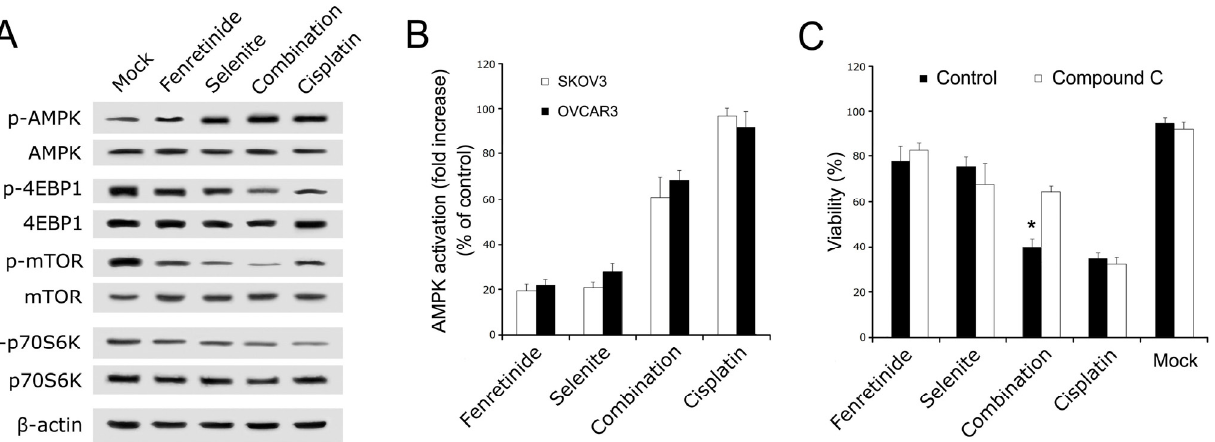
Figure 4. AMPK signaling pathway assay. After drug alone (10 µmol/L fenretinide, 10 µmol/L selenite) or drug combination (10 µmol/L fenretinide plus 10 µmol/L selenite) exposure for 48 h, Western blotting analysis for the expression of phosphorylated AMPK, 4EBP1, p70S6K and mTOR from AMPK signaling pathway ( A ); Cell-based enzyme-linked immunosorbent analysis for intracellular concentrations of phospho-AMPK of SKOV3 and OVCAR3 cells ( B ); Viability of SKOV3 cells under compound C (AMPK inhibitor) treatment ( C ). (means ± s.d., * p <